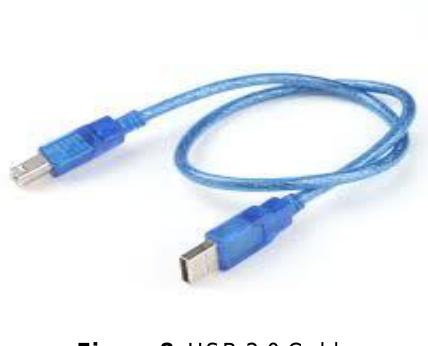
Figure 8. USB 2.0